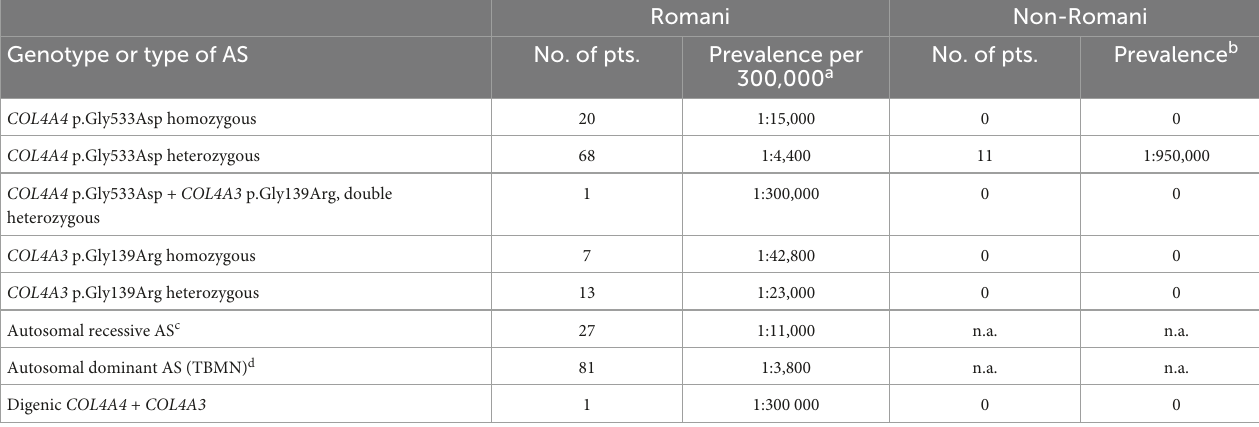
TABLE 2 Estimated prevalence of COL4A4 and COL4A3 variants in the Romani population in the Czech Republic. Romani